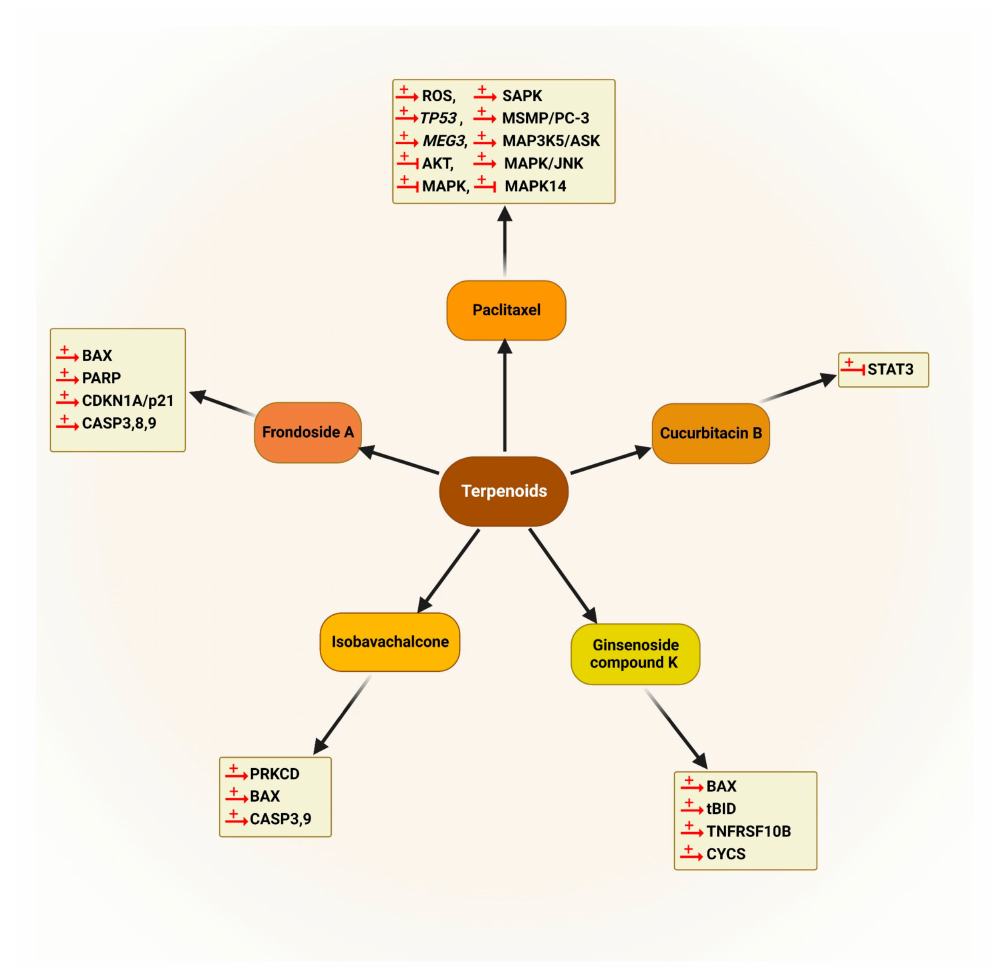
Figure 7. The schematic role of alkaloids on different proteins involved in the autophagy pathway. Alkaloids regulate autophagy in different ways. Vincristine and carbazoles have been demonstrated to inhibit autophagy by suppression of CD24, suppression of the PTEN-AKT-MTOR pathway and Figure 17. The schematic role of terpenoids on the proteins involved in the apoptosis pathway. These enhancement of SSQTM1/p62. Other alkaloids induce autophagy via activation of AMPK, TSC2, terpenoids increase the level of cleaved CASP3, CASP8 and CASP9 and induce the expression of MAPK/JNK-AP-1 and BECN1, and enhance MYC/c-Myc, LC3-II and ATG7 expression. Moreover, pro-apoptotic proteins (BAX, truncated BID (tBID) and CYCS) and CDKN1A/p21. Moreover, inhibi- inhibiting the AKT-MTOR pathway has a key function in induced autophagy by alkaloids. Moreo- tion of STAT3 phosphorylation, regulation of ROS and AKT-MAPK signaling and MAPK1/ERK2- ver, another alkaloid named tetrandrine induces autophagy by suppressing the WNT- CTNNB1/β - MAPK3/ERK1, as well as activation of PRKCD is observed in cells treated with these natural catenin pathway and decreasing MTA1 expression. → : Indicates activation or an increase in the mentioned protein expression. compounds. Moreover, the compounds activate MAP3K5/Ask1-MAPK14/p38 and MAPK/JNK- MAPK/SAPK pathways and increase the expression of MEG3 and TP53 . → : Indicates activation or an increase in the mentioned protein expression. : Indicates deactivation or a decrease in the mentioned protein expression. − and +: Indicate the effect of the proteins on different pathways ( − means negative effect and + means positive effect). The figure was created with BioRender.com. Licensing Right VD24OB6Q8E, 21 November